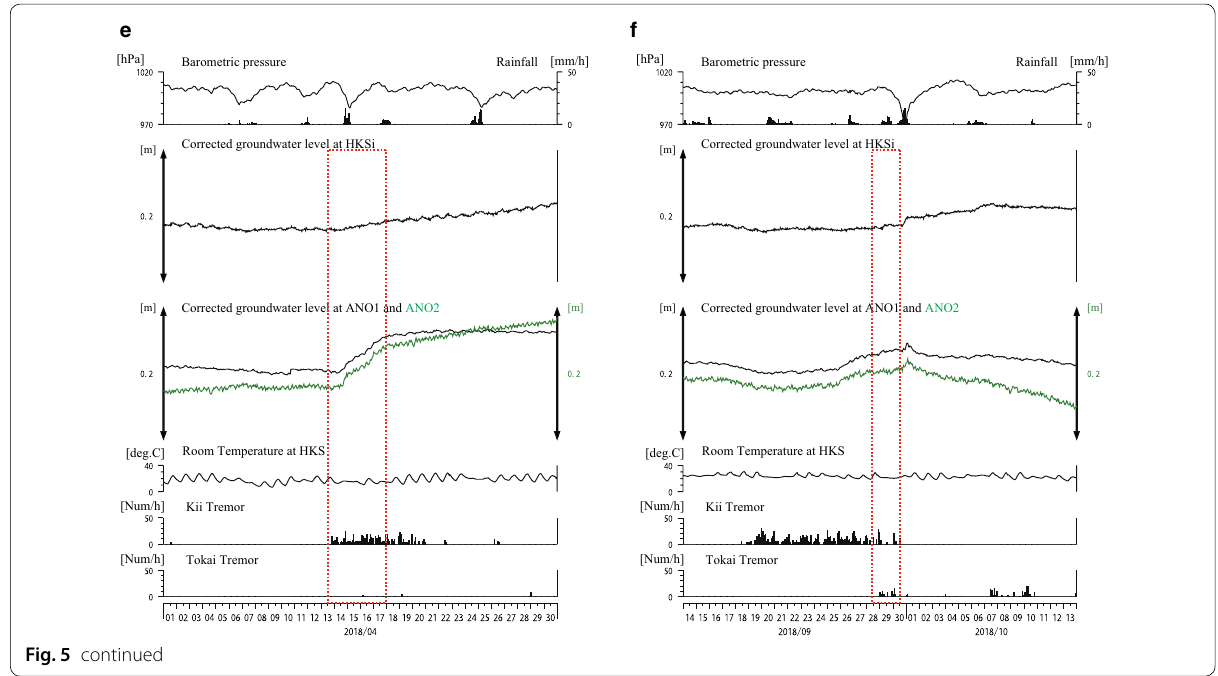
Table 2 Observational results at HKSi and predictions from the fault models Data range